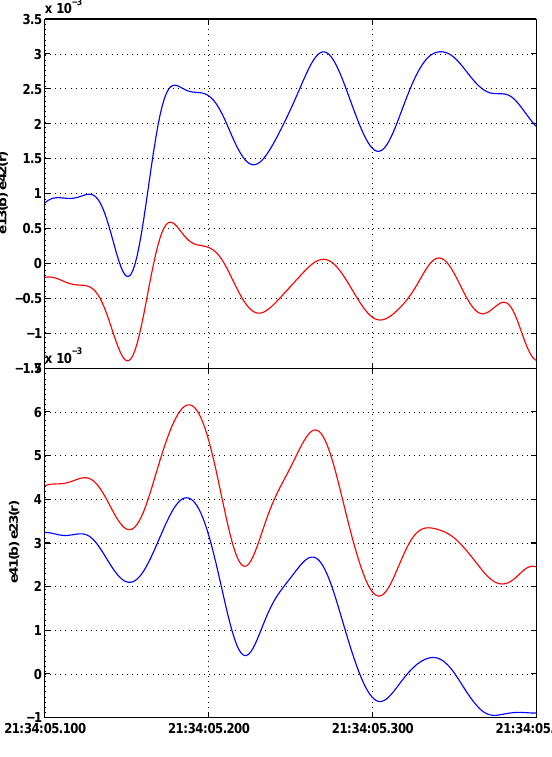
Fig. 6. The ω − k joint spectrum calculated from the phase differ- ences measured between the two perpendicular electric field com- ponents E 13 and E 41 for the first event.